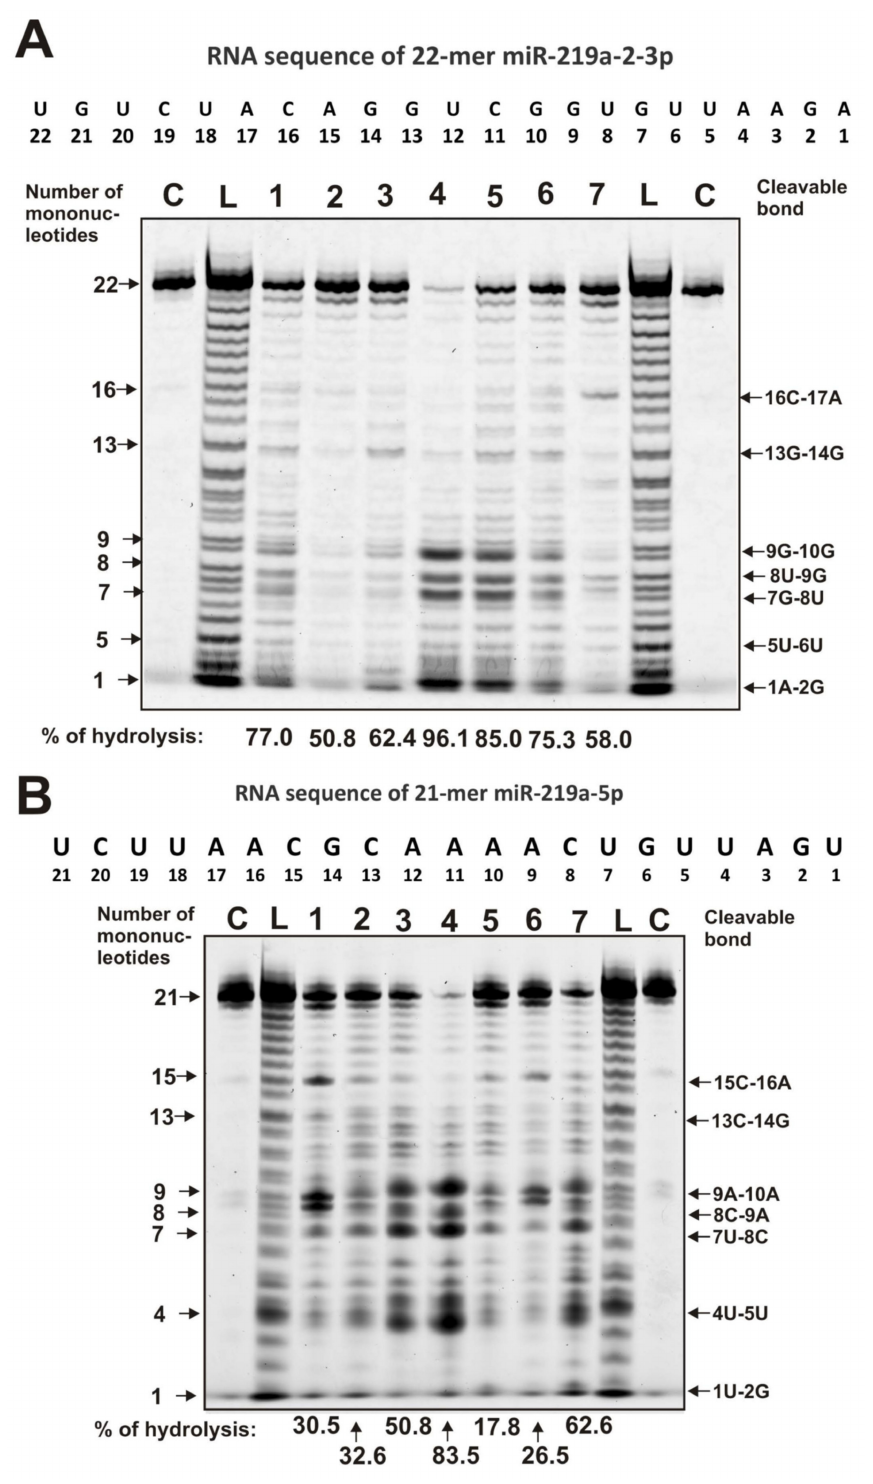
Figure 3. The patterns of 0.01 mg / mL F-miR-219a-2-3p ( A ) and F-miR-219a-5p ( B ) hydrolysis by seven human milk IgGs (lanes 1–7; 40 µ g / mL). The products of miRNAs hydrolysis were detected due to their fluorescence (5 (cid:48) -Flu residues) after reaction mixture incubation for 1 h. The numbers of IgGs, the lengths of the oligonucleotide products, and the percentage of miRNAs hydrolysis by each IgG preparation are indicated in panels A and B . The L lanes correspond to the markers of oligonucleotide lengths, while C lanes correspond to the substrates incubated without IgGs. The percentages of hydrolysis correspond to the average values of three independent